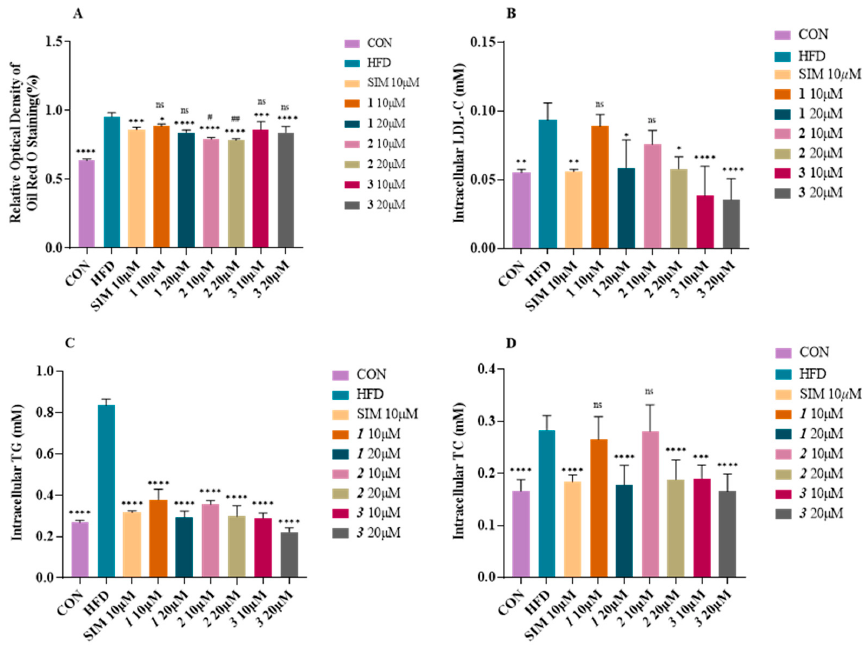
Figure 7. ( A ) Quantification analysis by Oil Red O staining. Data were the mean ± standard devia- tion (SD) by Prism; each group was compared with HFD group; * p < 0.05, ** p < 0.01, *** p < 0.001, and **** p < 0.0001 (one-way ANOVA). Every group except group CON and group HFD was com- pared with SIM 10 μ M group, ns p > 0.05, # p < 0.05, ## p < 0.01 (one-way ANOVA). Intracellular LDL- C ( B ), TC ( C ), and TG ( D ). Data were the mean ± standard deviation (SD) by Prism; each group was compared with HFD group; ns p > 0.05, * p < 0.05, ** p < 0.01, *** p < 0.001, and **** p < 0.0001 (one-way ANOVA).